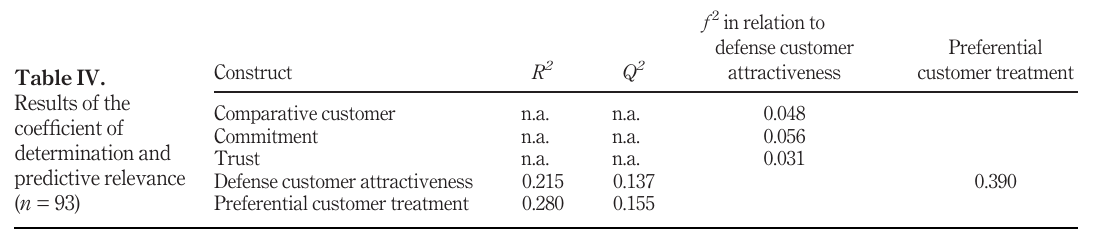
Table V. Results of the path coef fi cient without control